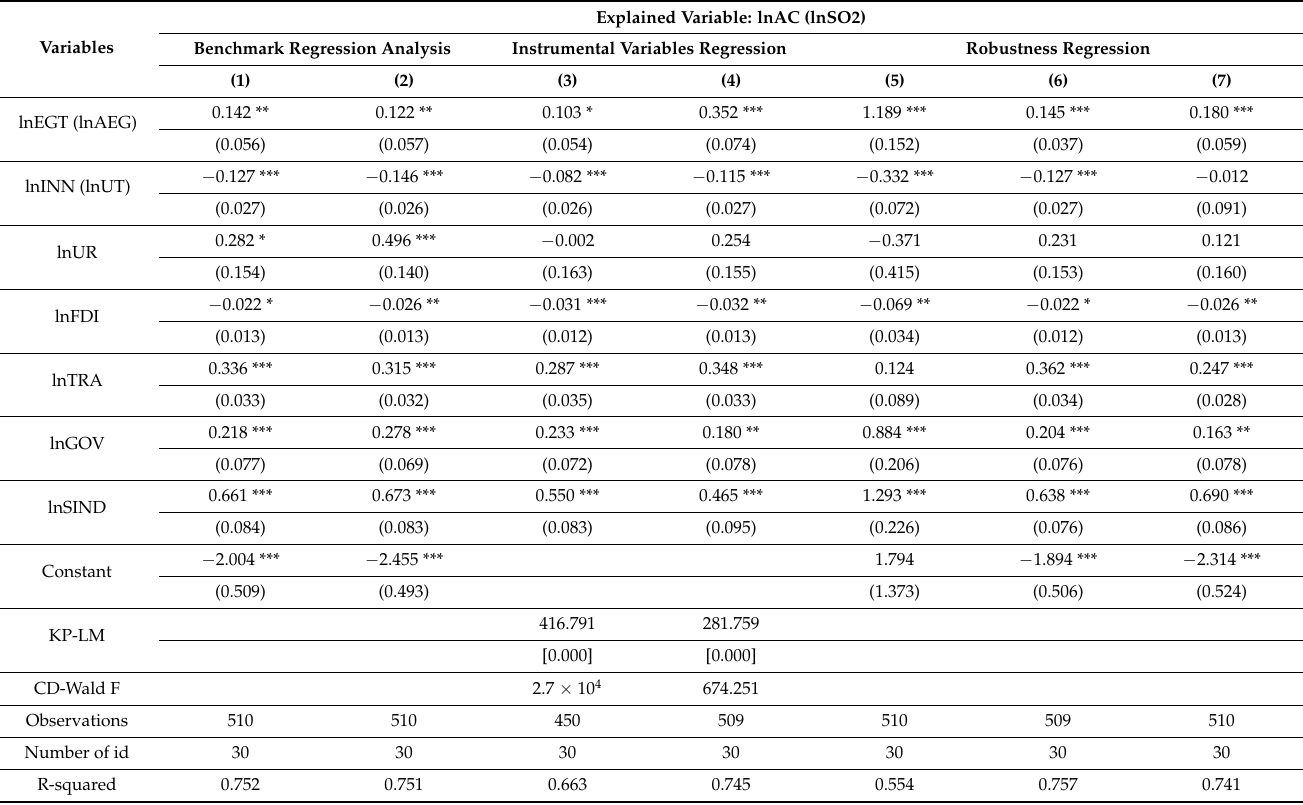
Table 3. The estimated results of the direct effect.